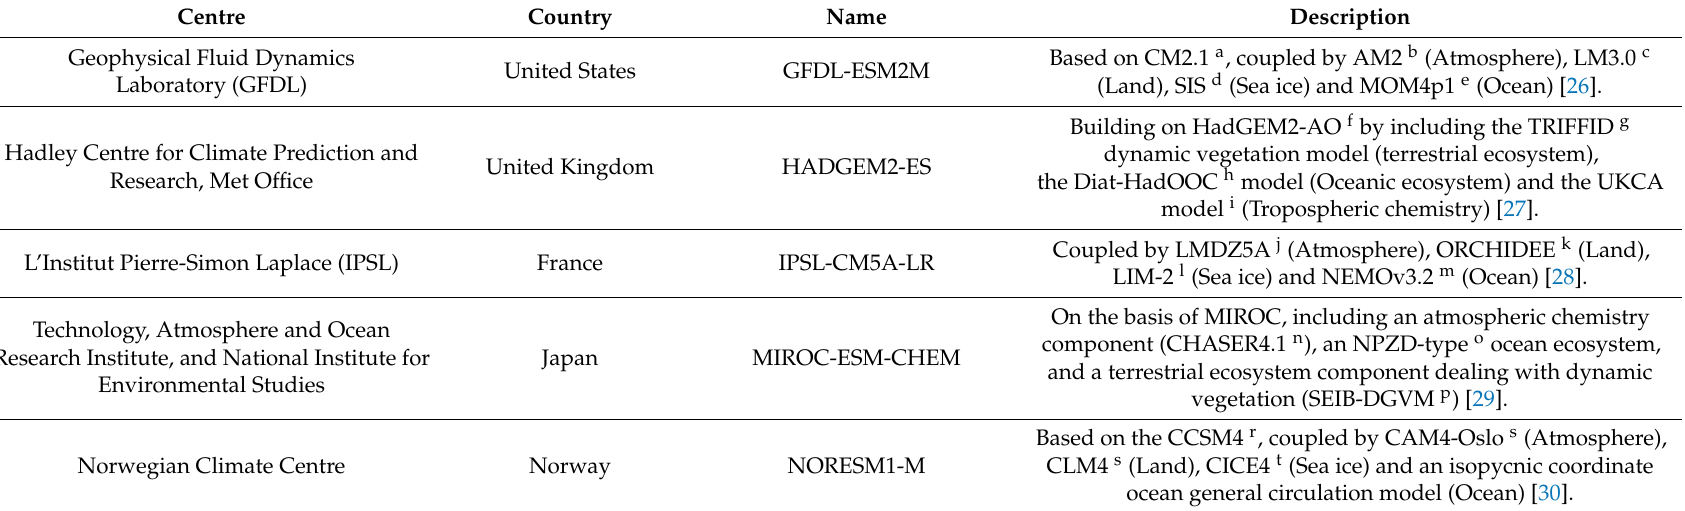
Table 2. The five models of the Fifth Coupled Model Intercomparison Project Phase (CMIP5) characteristics.